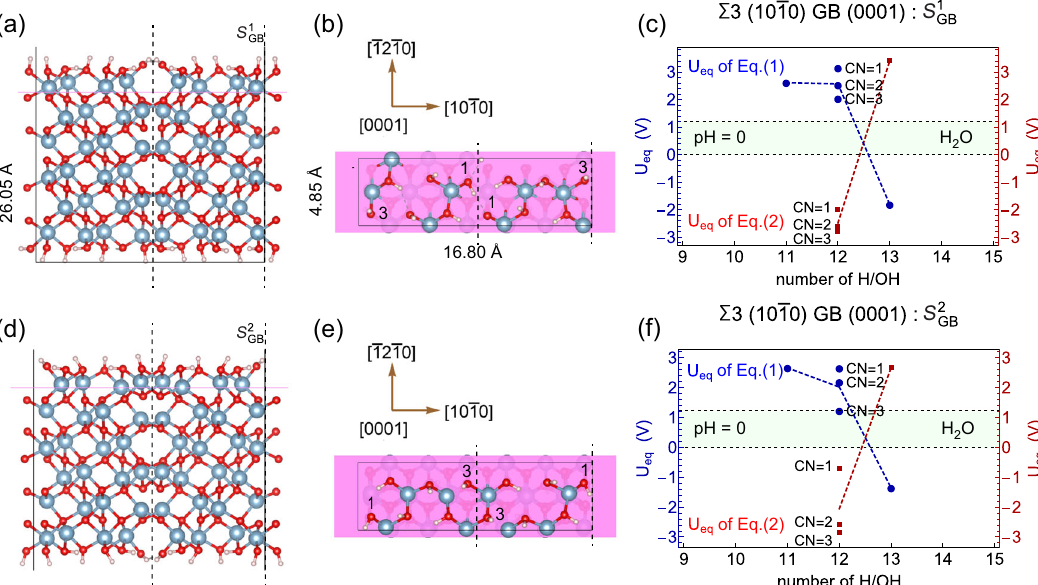
Fig. 3 Surface saturation of bicrystal α -Al 2 O 3 . a, b show the atomistic structure viewed from ½ 1210 (cid:3) and [0001] of the S 1 c shows equilibrium electrode potential U eq of Eq. (1) and Eq. (2) on (0001) surface of the S 1 on the top (0001) surface of the supercell, which corresponds to the number l in Eq. (1) and Eq. (2). Blue and red data points are for the equilibrium potential U eq of Eq. (1) and Eq.n (2), respectively, calculated based on the surface OH with different coordination numbers (CN) using Eq. (3) and Eq. (5). d – f show atomistic structure and U eq for the S 2